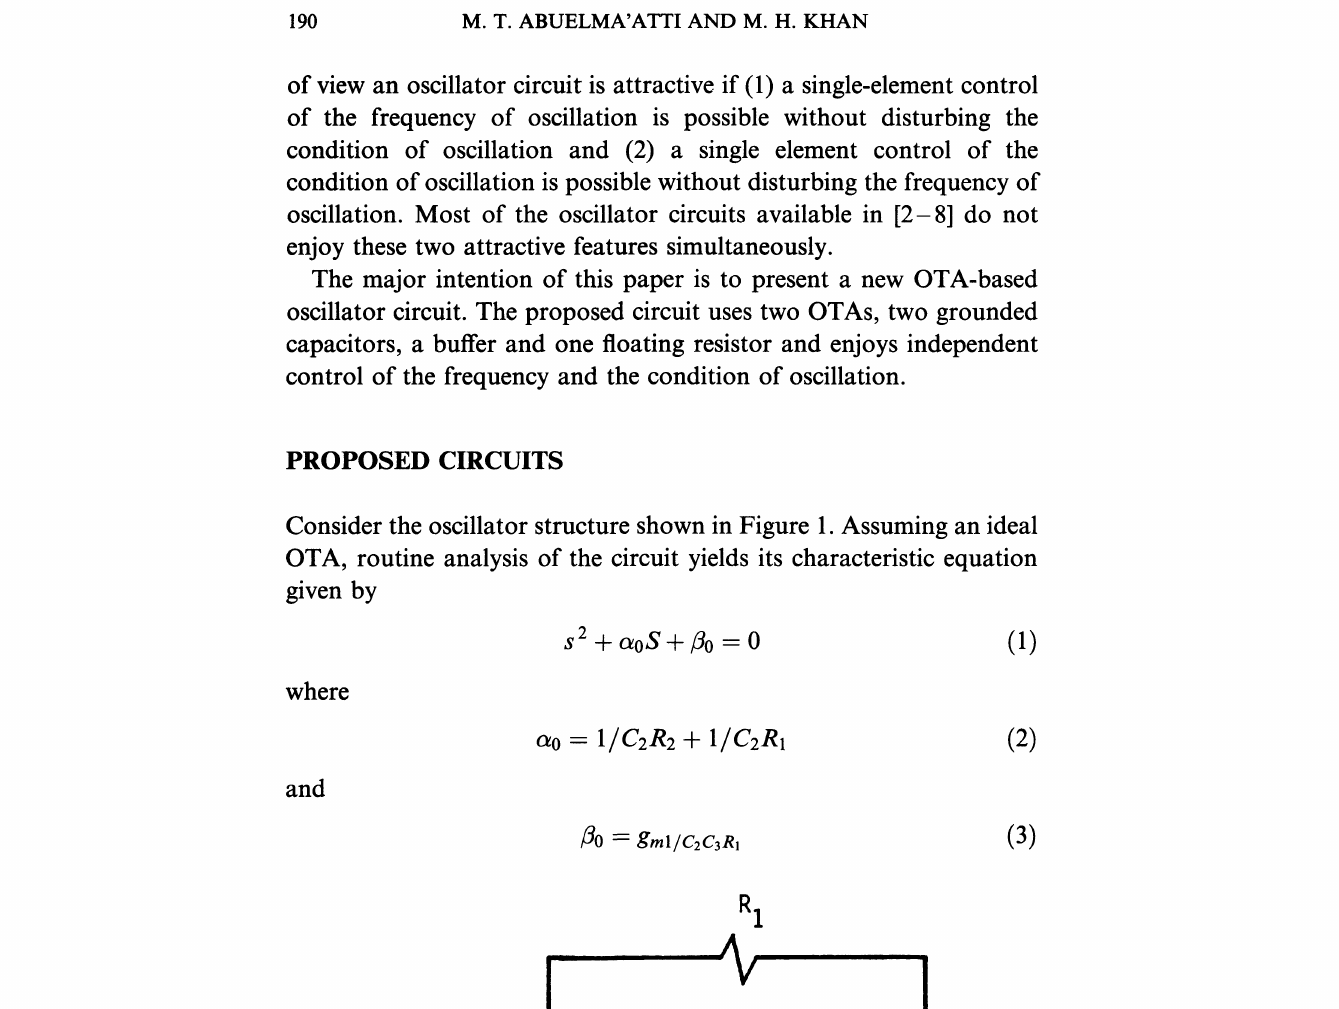
FIGURE Proposed Oscillator